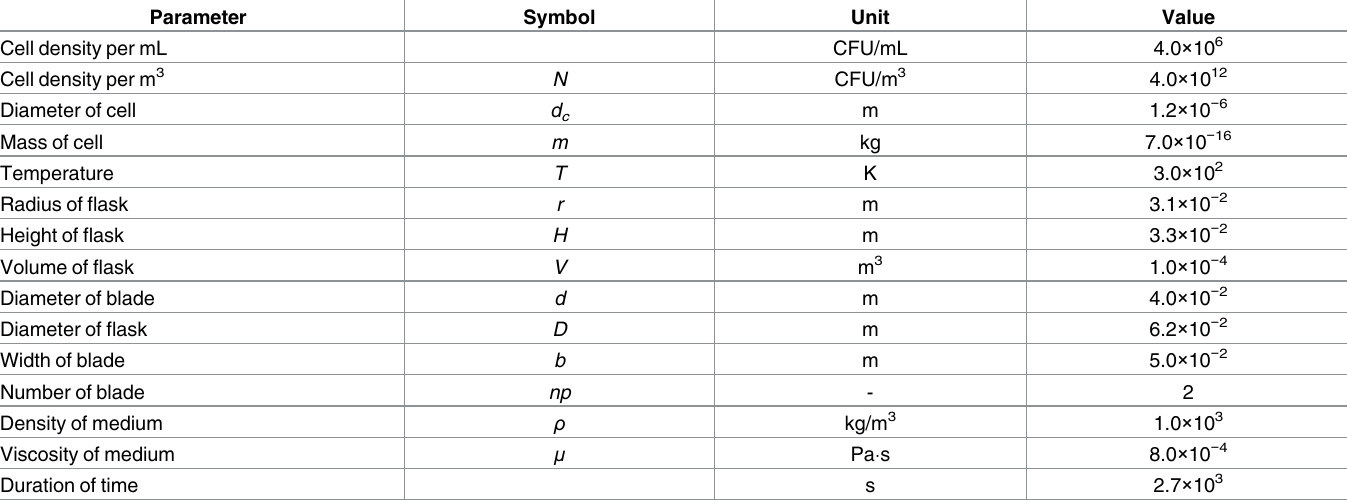
Table 2. Parameters used in the simulation of the number of cell-cell contact.